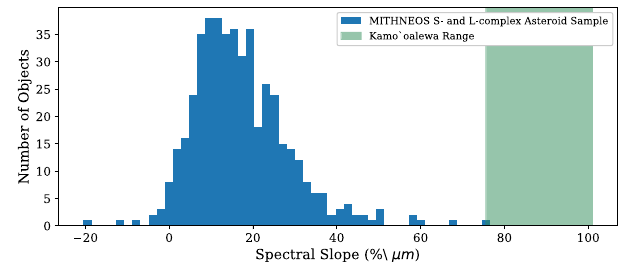
Fig. 3 Comparison of Kamo ʻ oalewa ’ s Spectral Slope with Typical NEAs. Histogram (50 equal-width bins) of S- and L-type asteroid spectral slopes from the MITHNEOS spectral survey of NEAs 26 . Our measured spectral slope for Kamo ʻ oalewa (green shaded region lies outside the typical range of 99.8% of the 470 S- and L-complex asteroids from the distribution shown in blue).